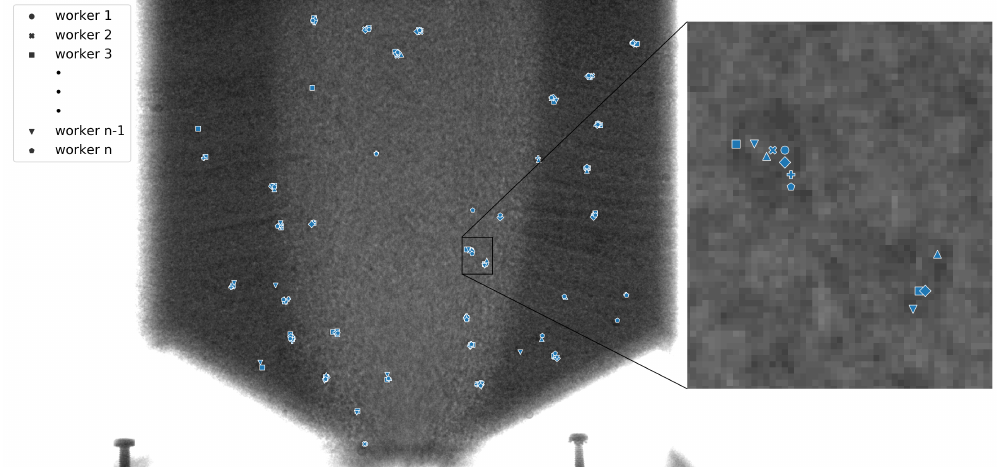
Figure 7. Example of the annotated X-ray image with noticeable discrepancies between the labels positioned by different workers. (Left) Full image view. (Right) Zoom-in showing slight shifts between the centers of markers set by different